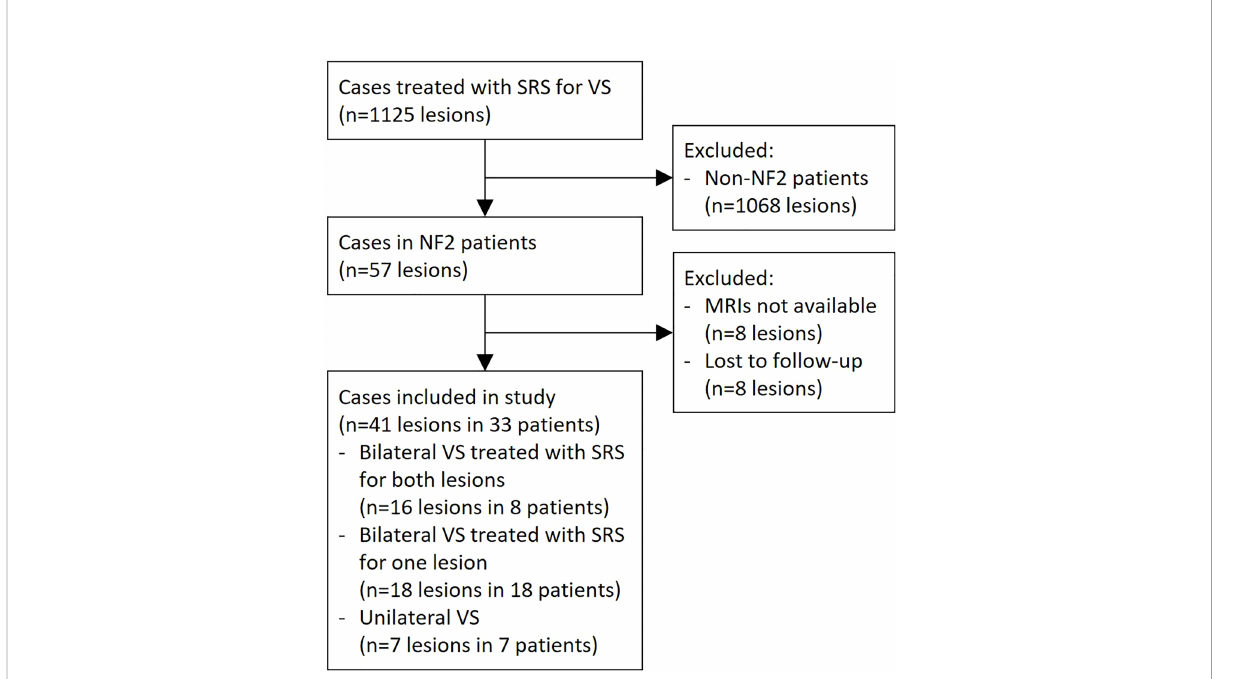
FIGURE 1 Selection of study subjects. NF2, neuro fi bromatosis type 2; MRI, magnetic resonance imaging; SRS, stereotactic